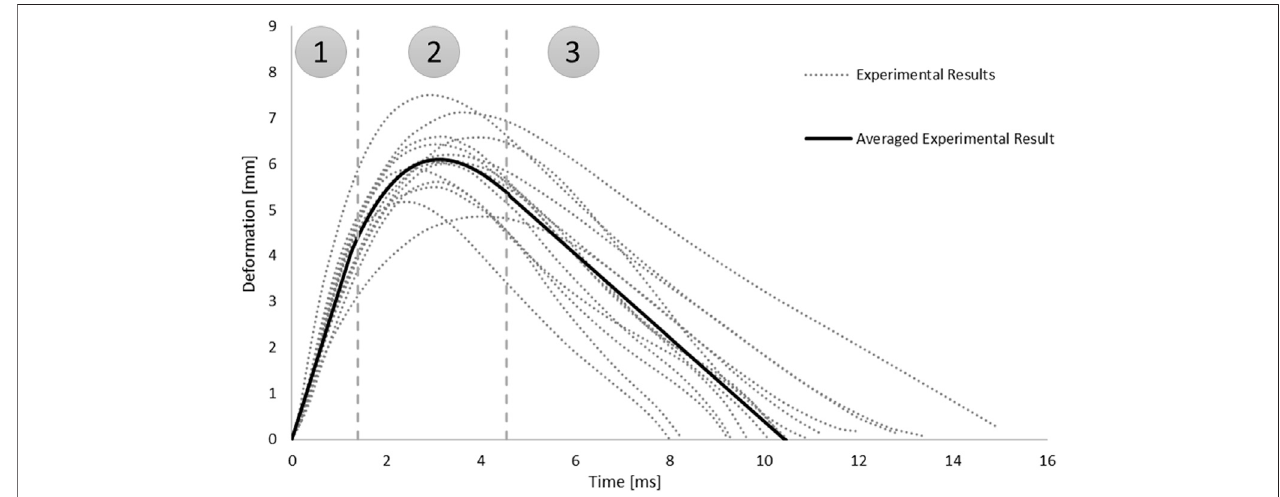
FIGURE 3 | Experimental trajectories including the average response for all impacts of Pellet I on the spinal Cord-pia mater complex divided into three regions: 1) loading, 2) rebound, and 3) unloading (Persson 2009).